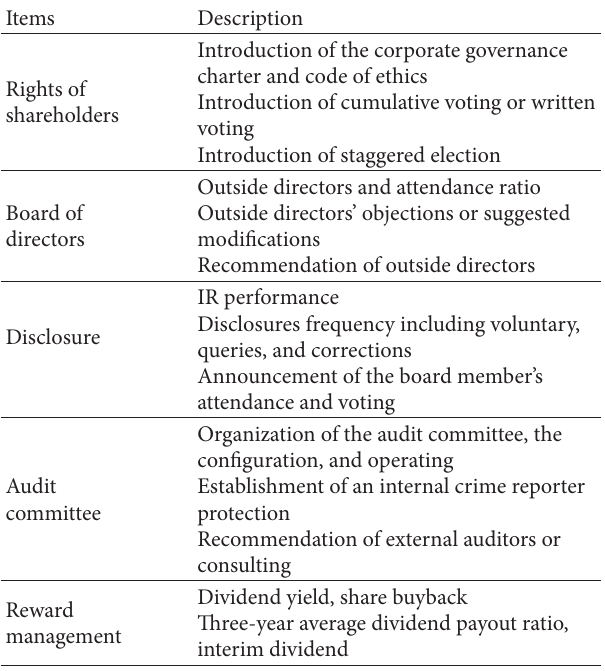
Table 1: Criteria of credit rating.